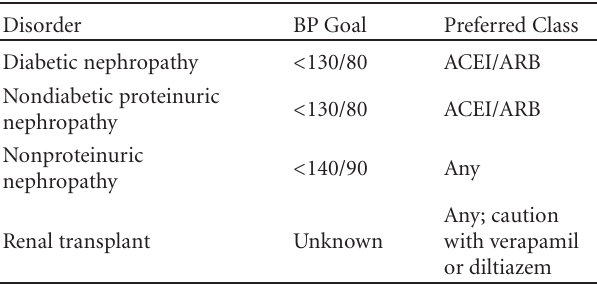
Table 2: Summary of treatment of hypertension in chronic kidney disease ∗